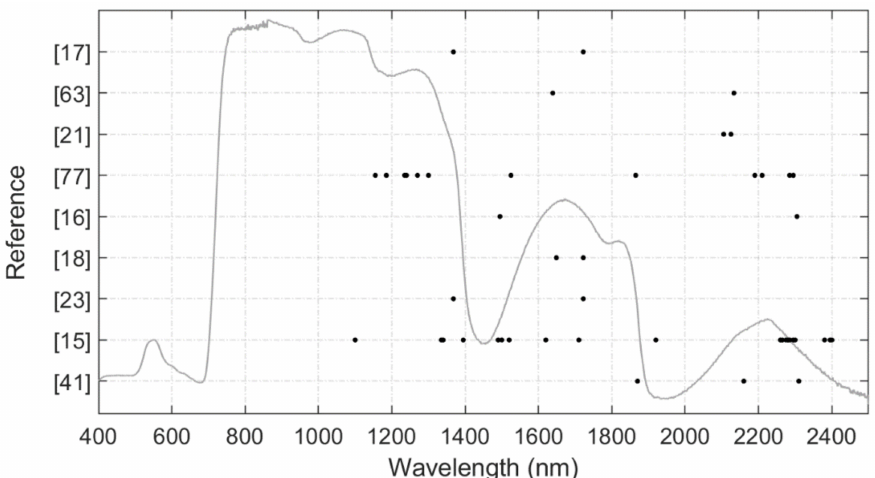
Figure 4. An overview of spectral wavelengths used in the literature to develop spectral indices to estimate LMA. A typical green leaf reflectance is plotted to improve